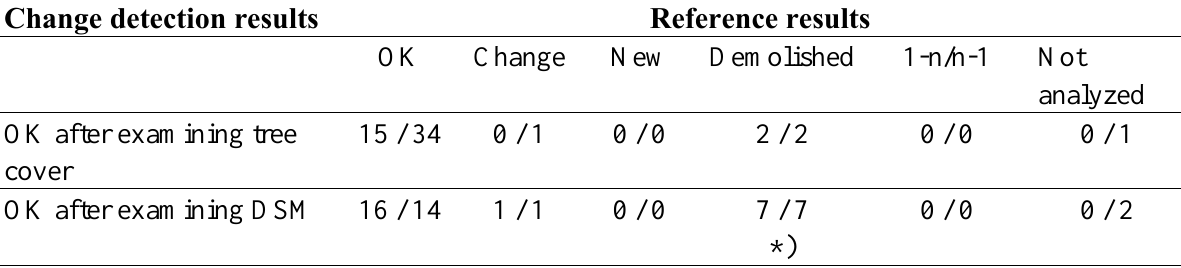
Table 6. Reference results for buildings classified as OK after applying the special correction rules (classes 7 and 8). All test areas included. The results are presented for the overlap / buffer